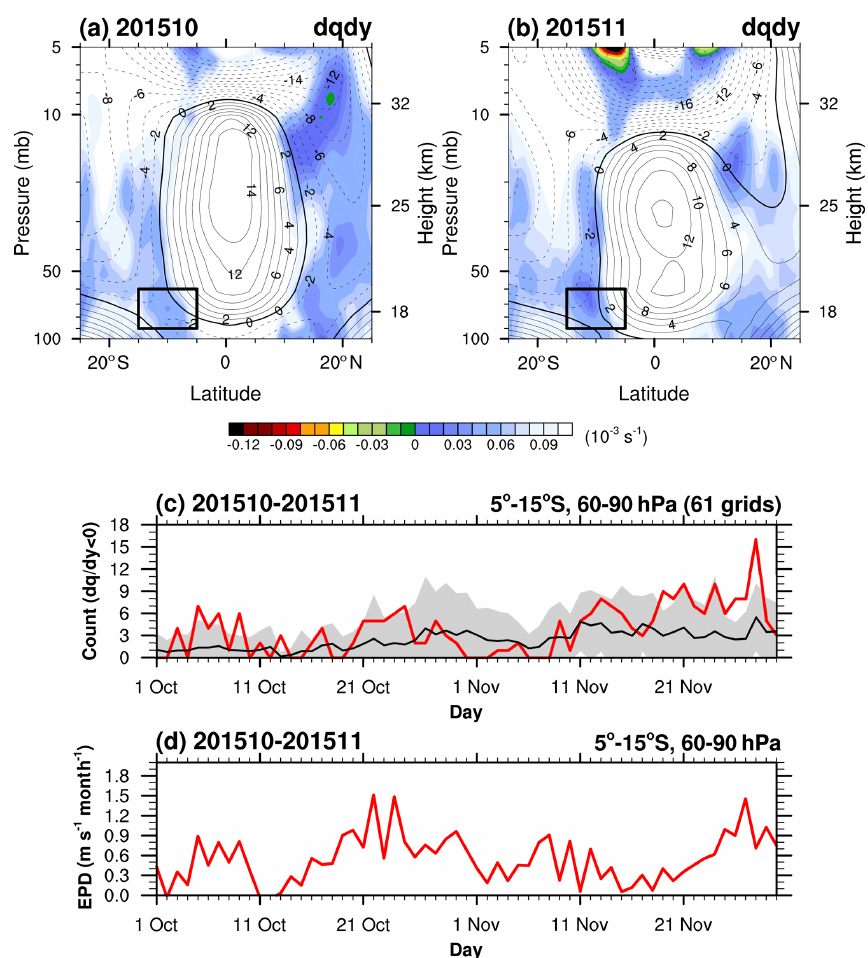
Figure 8. Latitude–height cross sections of the monthly mean ¯ q φ (shading) superimposed on the zonal-mean zonal wind (contour) in (a) Oc- tober 2015 and (b) November 2015. Positive (negative) zonal winds are plotted with solid (dashed) lines with a contour interval of 2ms − 1 , and thick contour lines denote a zero zonal wind speed. Daily time series of the (c) number of grids for which daily mean ¯ q φ (s − 1 ) is negative in the boxed region (5–15 ◦ S, 60–90hPa) and (d) those of the EPD for the MRG waves averaged over the boxed region in October–November 2015 (red). Black lines in (c) are for the climatology with ± 1SD (gray